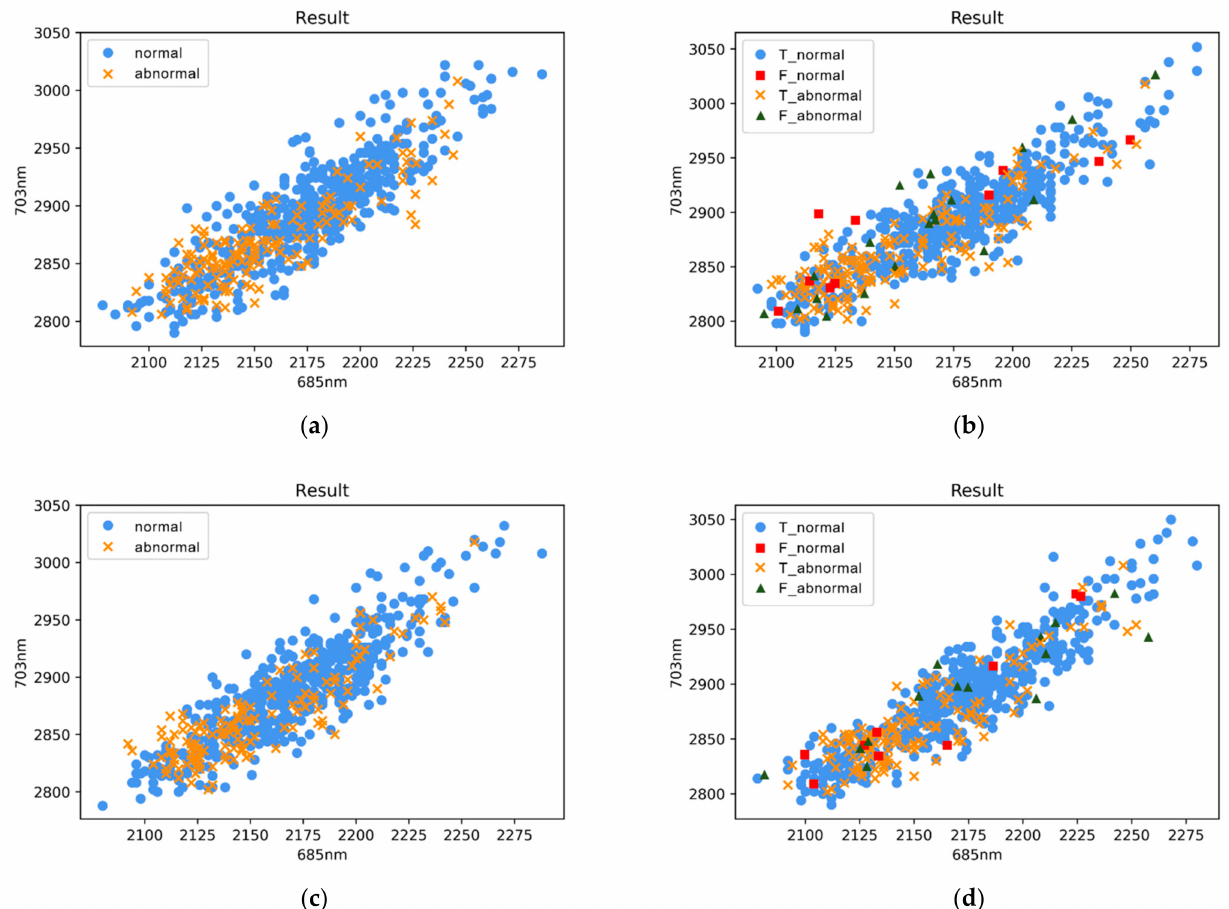
Figure 7. 2D plotting of modeling classification results: with state variable identification (SVID) and optical emission spectroscopy (OES) data of ( a ) train data and ( b ) test data; with only OES data of ( c ) train data and ( d ) test data.